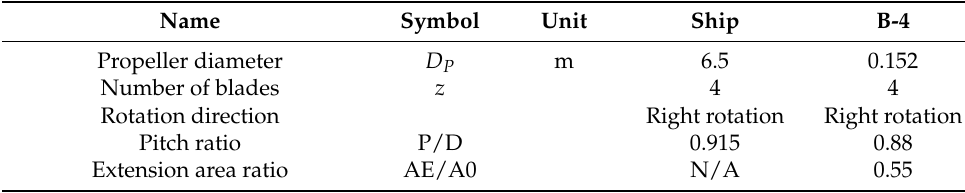
Table 3. B-4 Propeller elements ( λ =